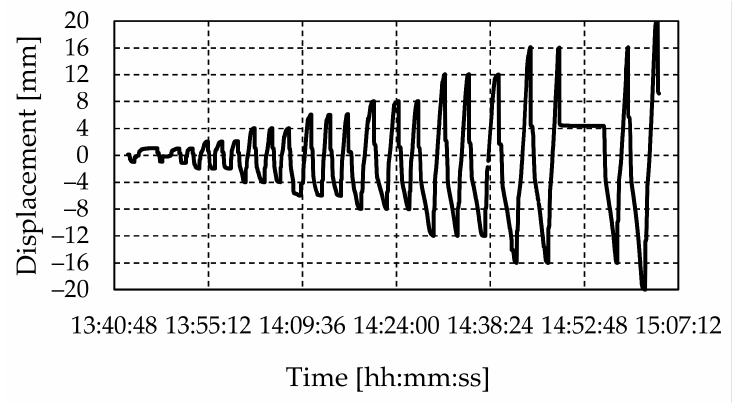
Figure 9. Loading program of the wall